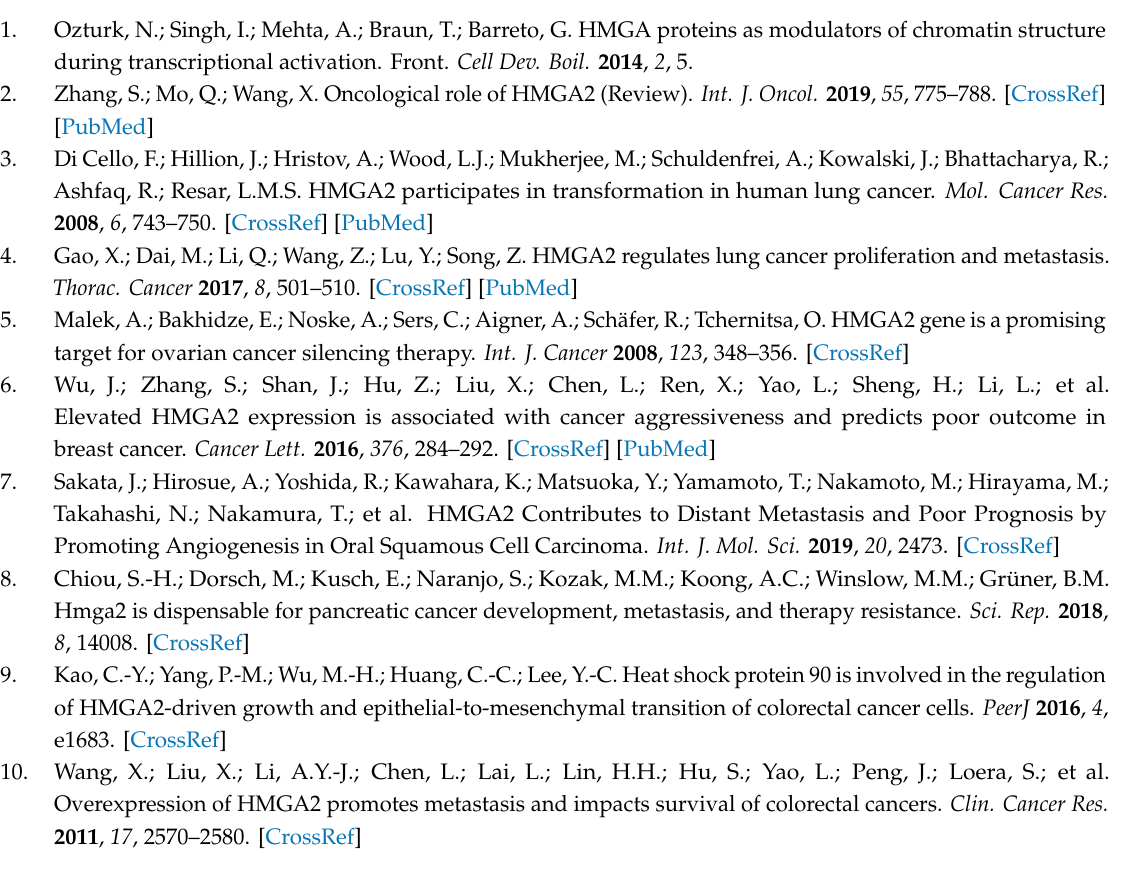
Table S1: Top 10 chemical perturbagens with negative enrichment score for gene expression signature of overexpression of HMGA2. Table S2: Top 10 chemical perturbagens with positive enrichment score for gene expression signature of knockdown of